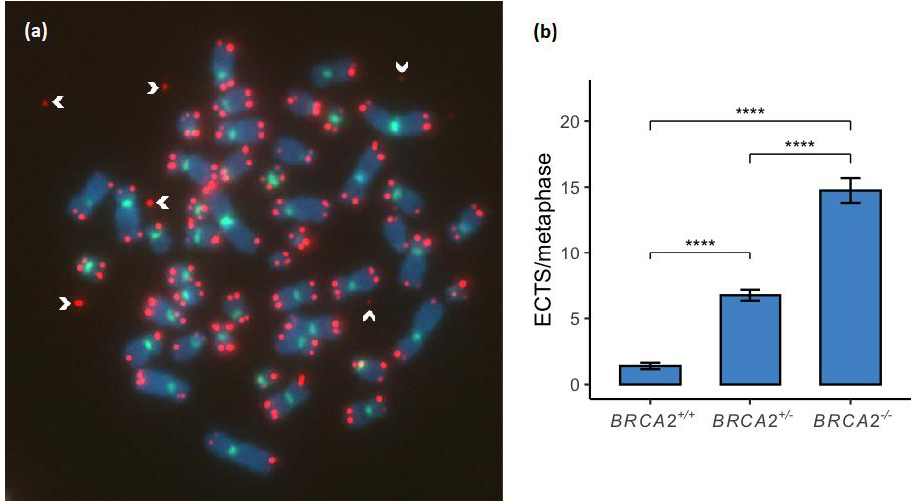
Figure 4. Extrachromosomal telomere sequences (ECTS) were compared between the BRCA2 geno- types. ( a ) ECTS were measured as telomeric signals (red) scattered around the chromosomes (white arrowheads). ( b ) ECTS were found to be significantly increased between the genotypes of BRCA2 +/+ , BRCA2 +/ − and BRCA2 − / − in a stepwise manner ( p < 0.0001). **** corresponds to p < 0.0001. Metaphase chromosomes were analyzed with FISH by Cy3-conjugated telomere probe and FITC-conjugated centromere probe and counterstained with DAPI. The metaphase shown is from the EB2302 BRCA2 +/ − lymphoid cell line.